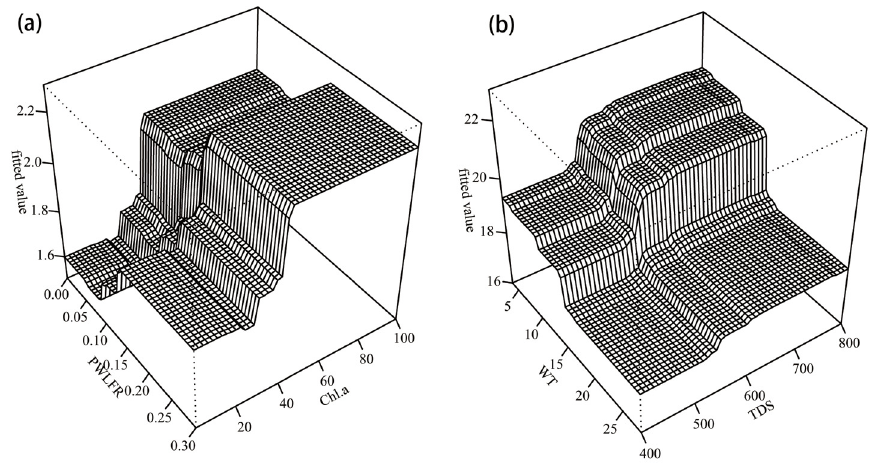
Figure 5. Three-dimensional partial dependence plots for the strongest interaction in the BRT model for species abundance in ( a ) summer and ( b ) spring and autumn. Chl a : Chlorophyll a ; PWLFR: The percentage of water level fluctuation range; WT: Water temperature; TDS: Total dissolved solids.